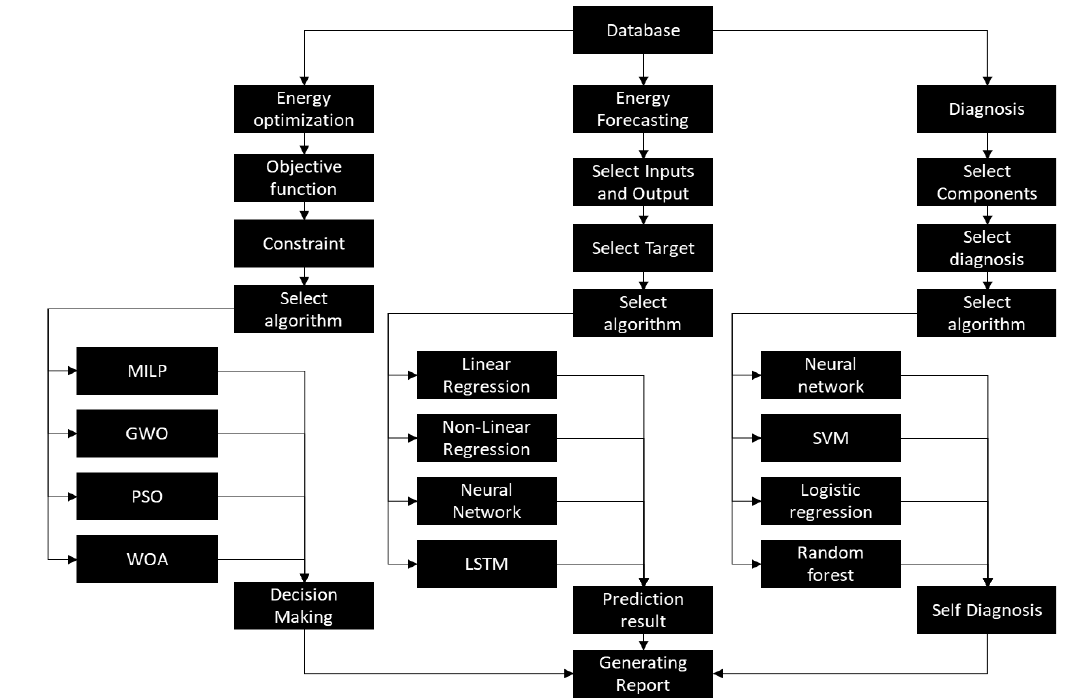
Figure 22. Flowsheet of different steps to apply different artificial intelligence algorithms.